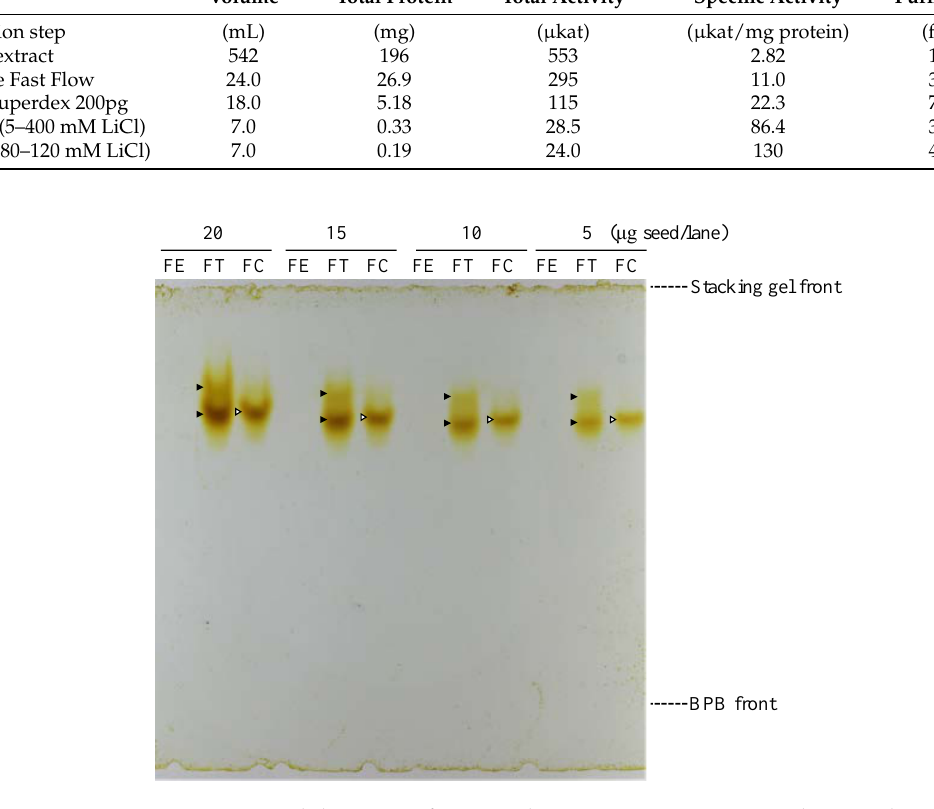
Figure 2. In-gel detection of rutinosidase isozyme in FE, FT, and FC seeds. In-gel detection was performed using a rutin–copper complex. To obtain clear staining images, we considered a sample volume corresponding to 5–20 µg seeds per lane. Table 2. Kinetic constants of purified rutinosidase for